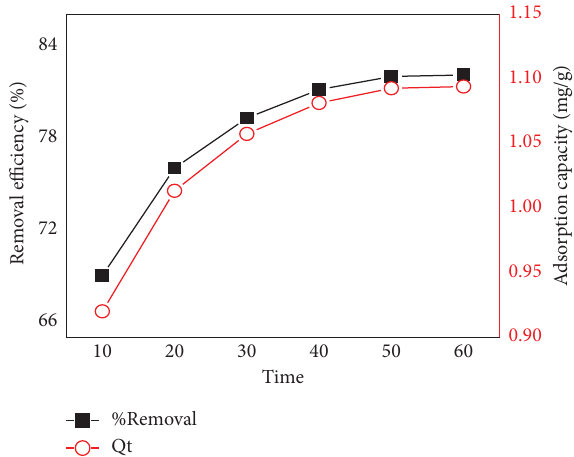
Figure 9: Adsorption capacity and removal efciency of HAp NP as a function of contact